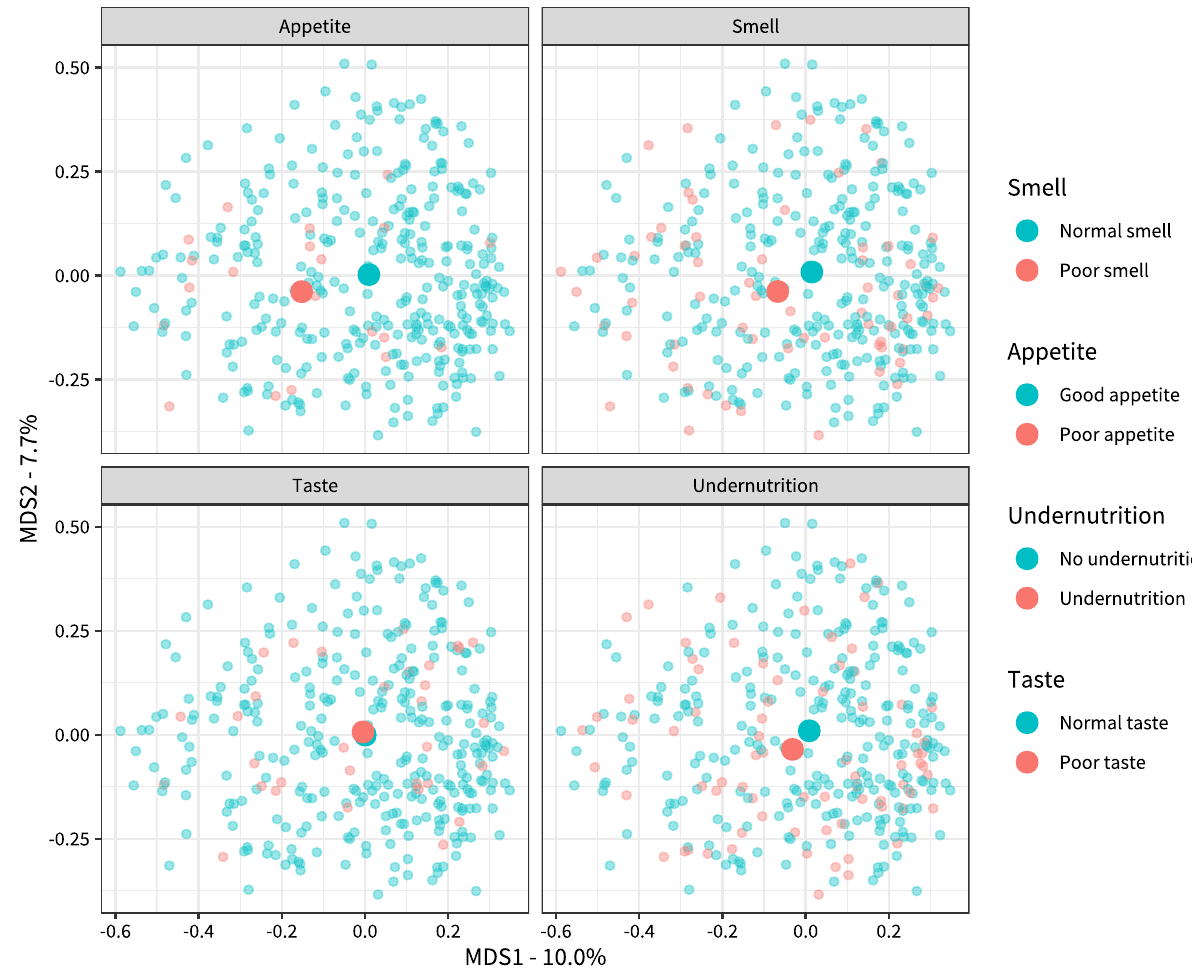
Figure 2. Ordination plots for Bray–Curtis dissimilarity colored for poor taste, smell, appetite, and undernutrition. Multi-dimensional scaling (or principal coordinate analysis) of the Bray–Curtis beta- dissimilarity in microbiota data. Each dot represents the microbiota sample of a single participant. Distance between samples represents the dissimilarity of these samples from each other. The axes represent 10.0% and 7.65% of variation in Bray–Curtis Distance. Samples are colored according to appetite, smell, taste, and undernutrition. MDS Multi-dimensional